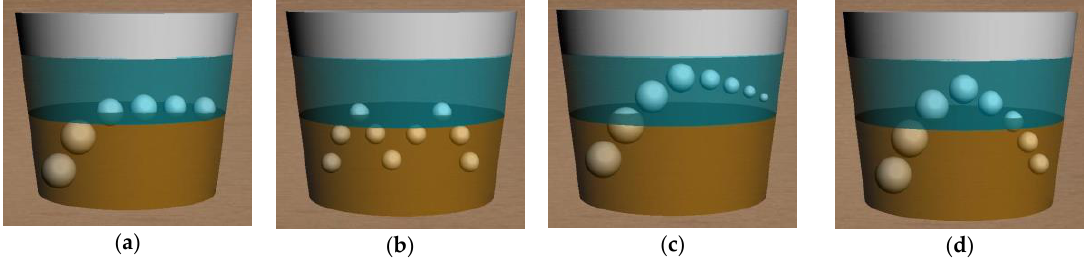
Figure 24. The four types of inclusion behavior at the steel-slag interface ( a ) Remain; ( b ) Oscillate; ( c ) Pass and dissolve; ( d ) Pass and then return back.